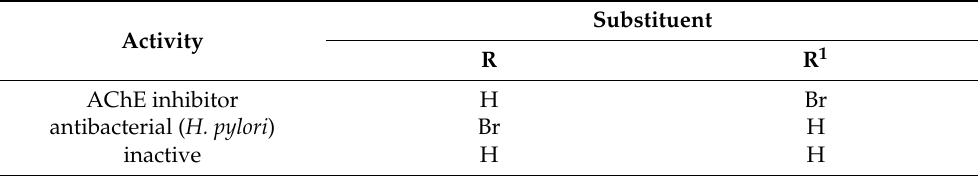
Table 4. The dependence of the activity of petrosamine analogs 176 – 178 on the type of substituents. Activity